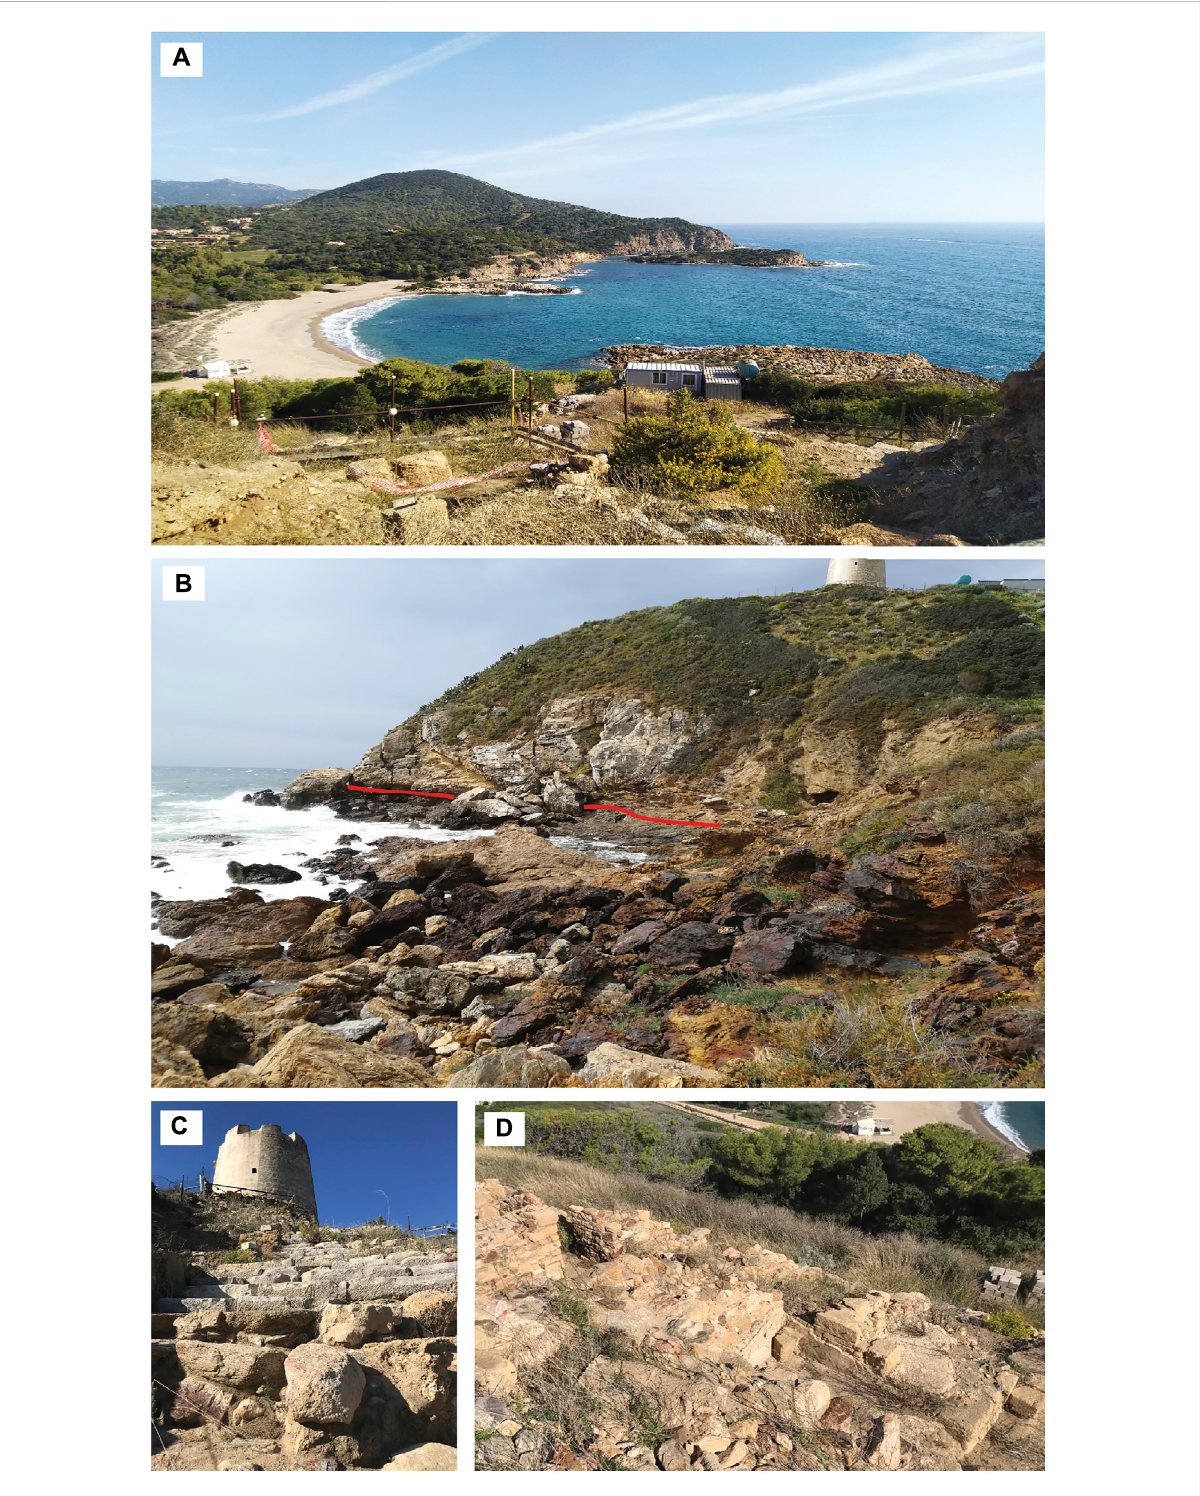
FIGURE 3 (A) Panorama from the tower looking toward east; (B) overview of the geology of the Chia tower hill — the red line highlights the transition between,frombottomtotop,darkphyllitesandmetadolostones/marblesoftheBithiaFormation; (C) Spanishtoweroverlooking the Bithia ruins; (D) Bithia Punic/Roman